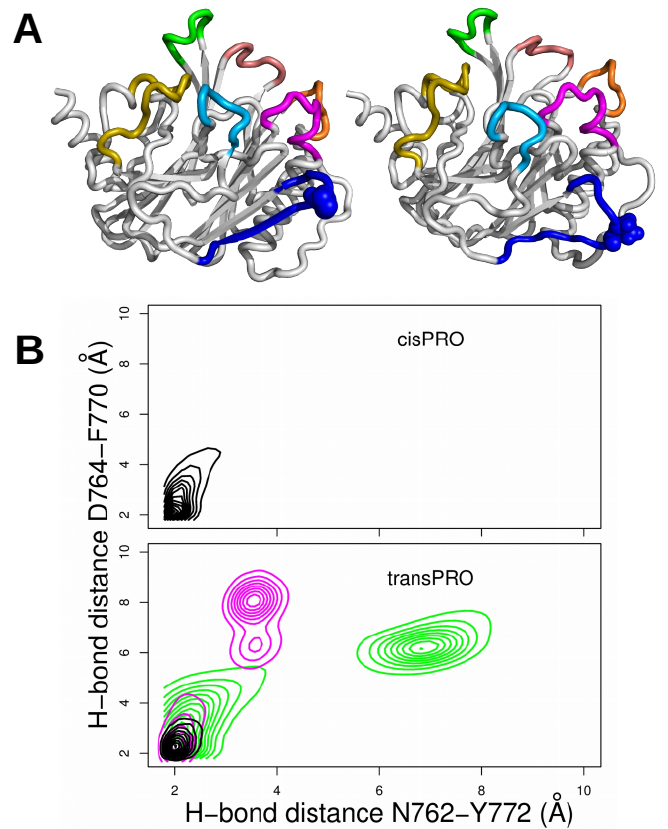
Figure 7. ( A ) Comparison between the 1HQ0 PDB structure (left) and a conformation from the tr768_100 trajectory (right). The loops are colored as in Figure 1. P768 is drawn in spheres and colored blue, and the region 769–775, close to loop L1, is also colored blue. ( B ) Plots of the hydrogen bond distance between D764 and F770 (Å) with respect to the hydrogen bond distance between N762 and Y772 (Å). The hydrogen bond distances are defined as distances between the carbonyl oxygen of F770 and the amide hydrogen of D764 and between the backbone carbonyl oxygen of N762 and the amide hydrogen of Y772. The plots were realized for all trajectories with cis conformations of X-Pro imide bonds (top plot) and for all trajectories with trans conformations of X-Pro imide bonds (bottom plot): tr100 (black), tr768_100 (magenta), tr968_100